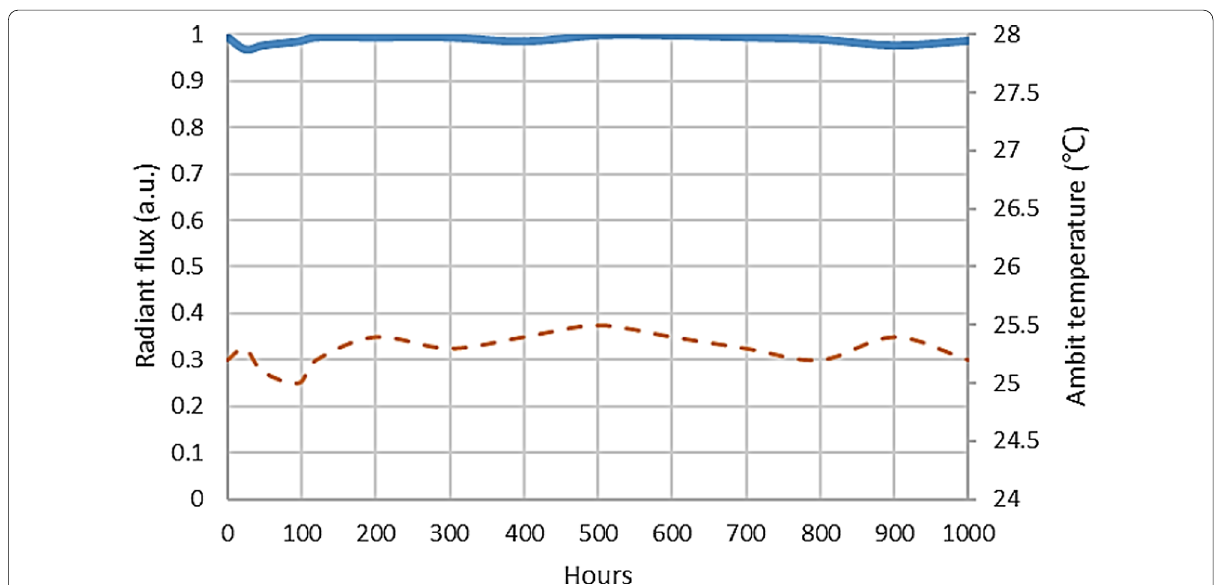
Fig. 12 The long‑term stability test of HRTF